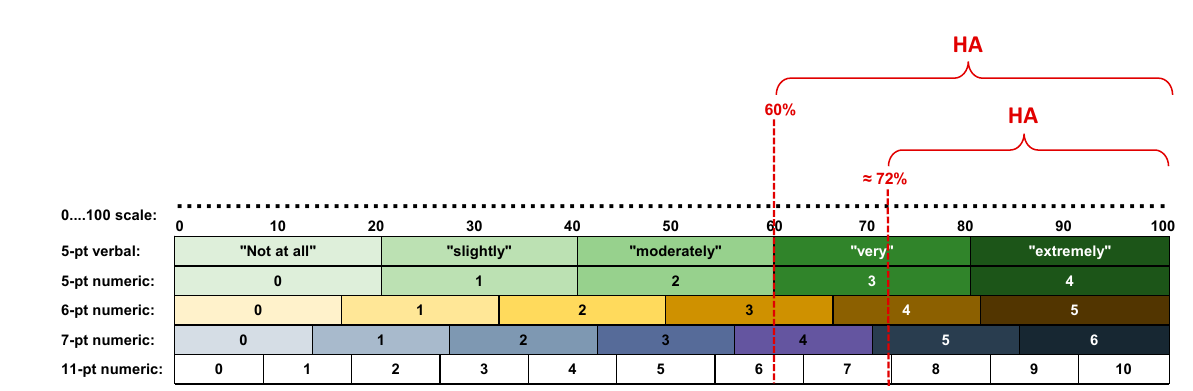
Figure 2. Commonly used noise annoyance scales and location of the most commonly used cutoff points 60% and ≈ 72% (red dashed lines) that are used to define a “highly annoyed” (HA) response.